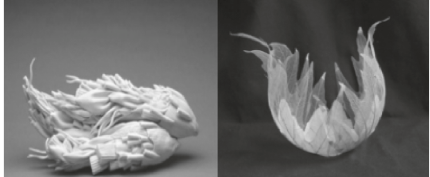
Figure 6: Contemporary handicraft three-dimensional fiber art